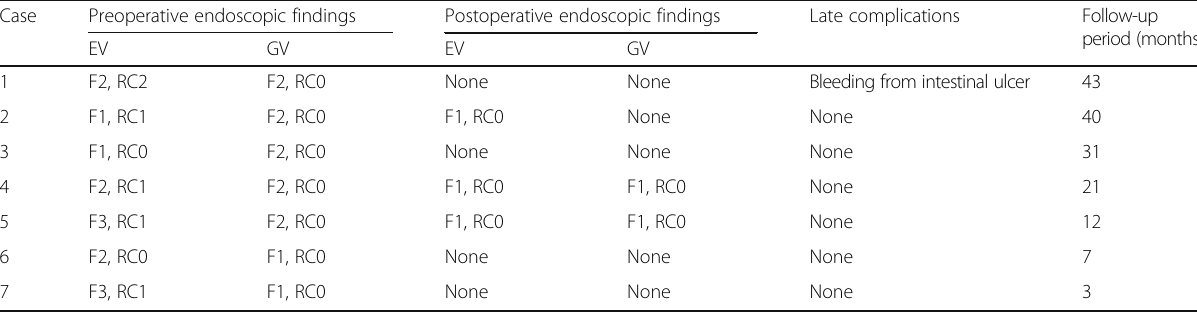
Table 3 Endoscopic findings and late complications on seven patients Case Preoperative endoscopic